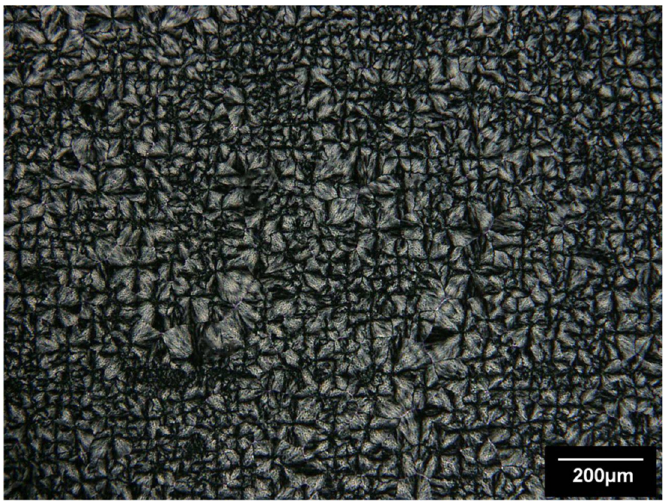
Figure 7. PE spherulites observed by optical microscopy in combination with polarized light at ambient temperature.